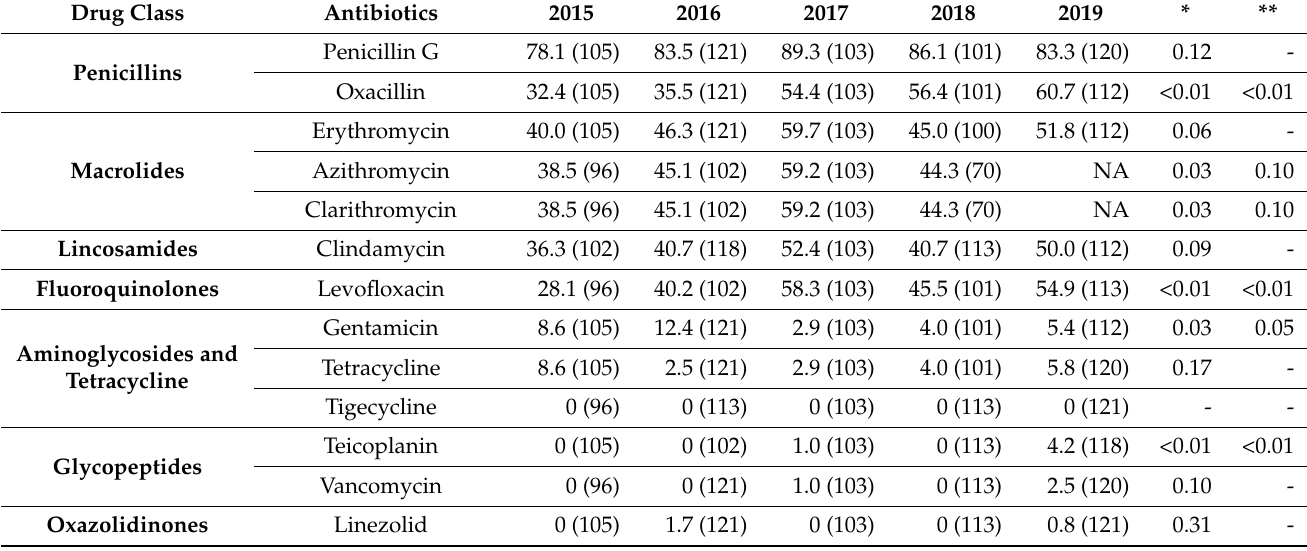
Table 7. Antimicrobial resistance profile of Staphylococcus aureus to antibiotics used in Hospital.